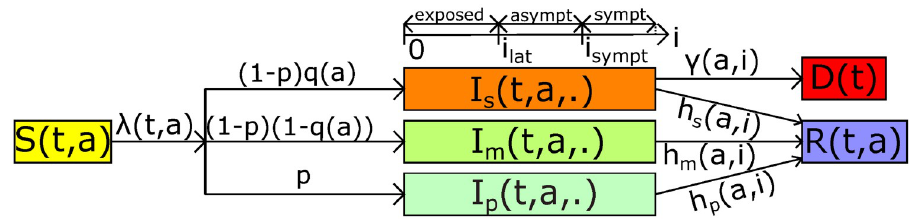
Fig 1. The model flow diagram. Susceptible hosts of age a at time t ( S ( t , a )) are exposed to the virus with a force of infection λ ( t , a ). A fraction p of exposed individuals, which are infected since time i , will never develop symptoms and enter the group of paucisymptomatic infections ( I ( t , a , i )). The rest will develop symptomatic infections, either severe p ( I ( t , a , i )) with proportion q ( a ) depending on age a of individuals, or mild ( I ( t , a , i )). Exposed individuals remain s m non-infectious for a duration i lat after infection. Next, they become asymptomatic infectious and only symptomatic after infection. Infected individuals recover at rate h ( a , i ). Only severely infected will develop symptoms at time i sympt v infected of age a die from the infection at rate γ ( a , i ). Notations are shown in Table